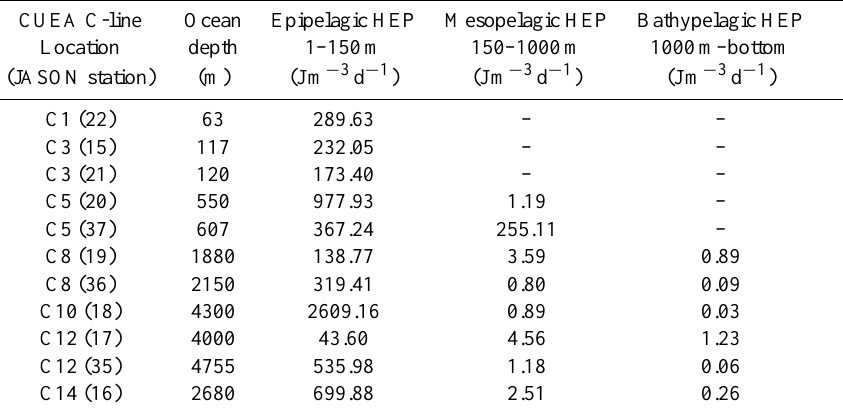
Table 7. HEP as ATP production in epipelagic, mesopelagic, and bathypelagic waters of the C-line section, September 1976. Shoreward of C5 the bottom limits the lower depth